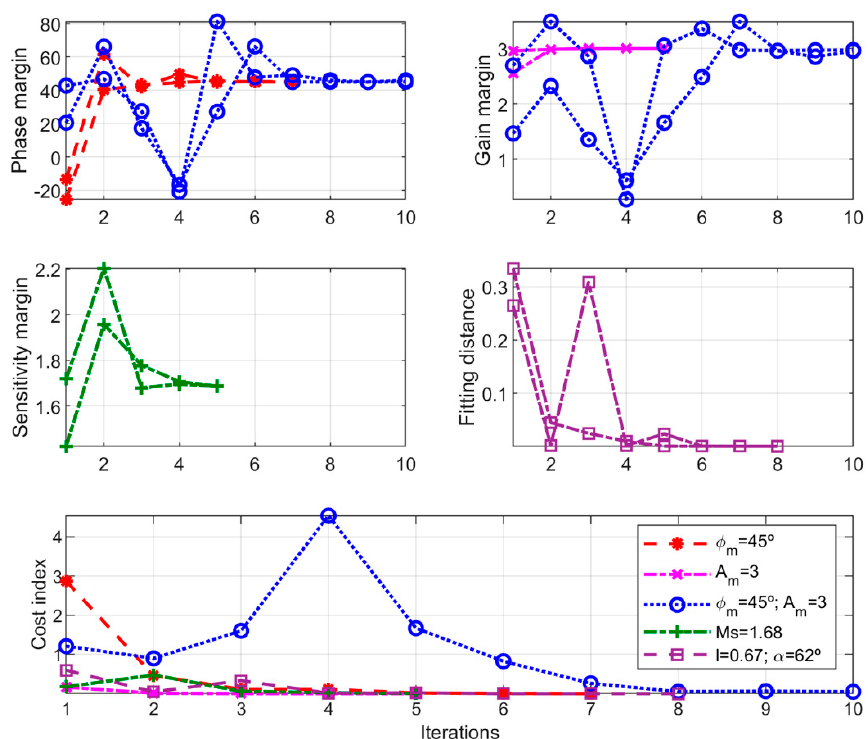
Figure 9. Progression of the design specifications and cost index through the proposed procedure in example 1.